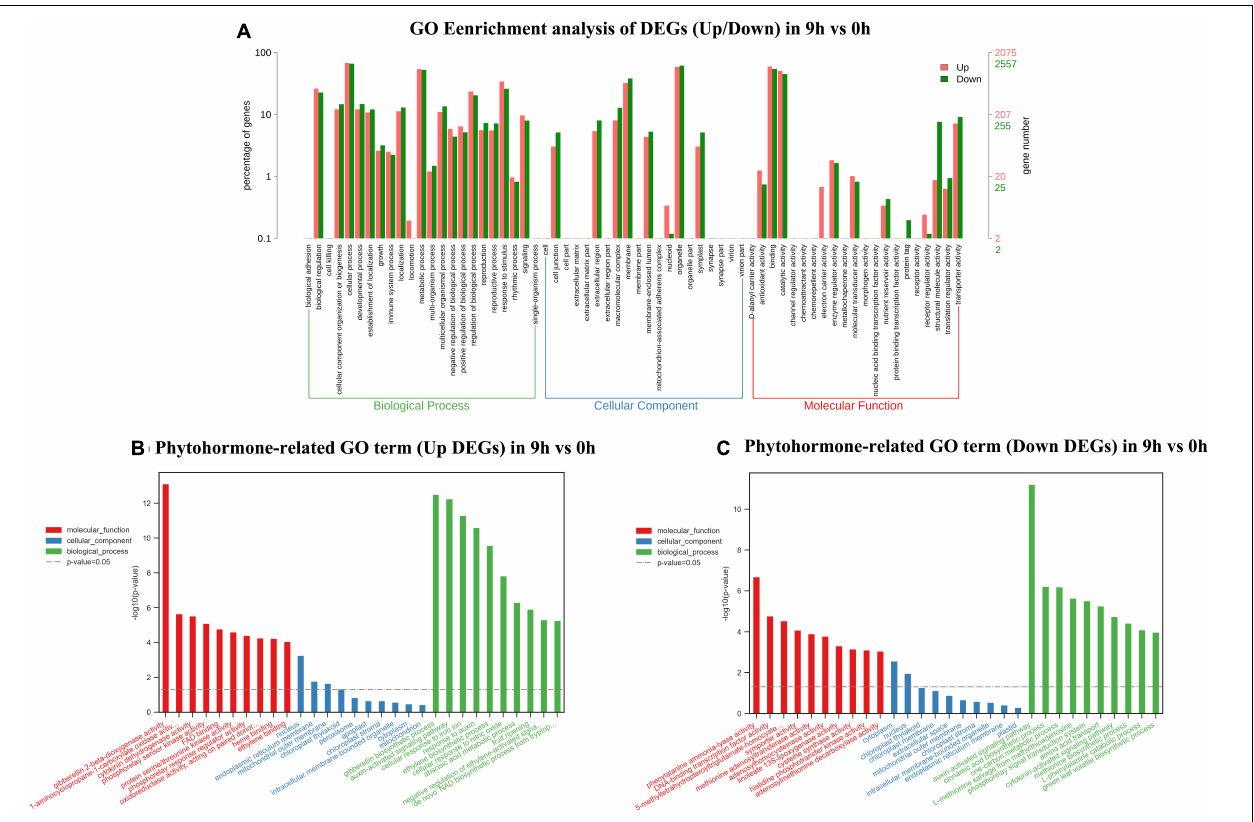
FIGURE 3 | Gene ontology (GO) enrichment analysis of up/down differentially expressed genes (DEGs) (A) , phytohormone-related GO terms (up DEGs) (B) , and phytohormone-related GO terms (down DEGs) (C) in 9 vs. 0